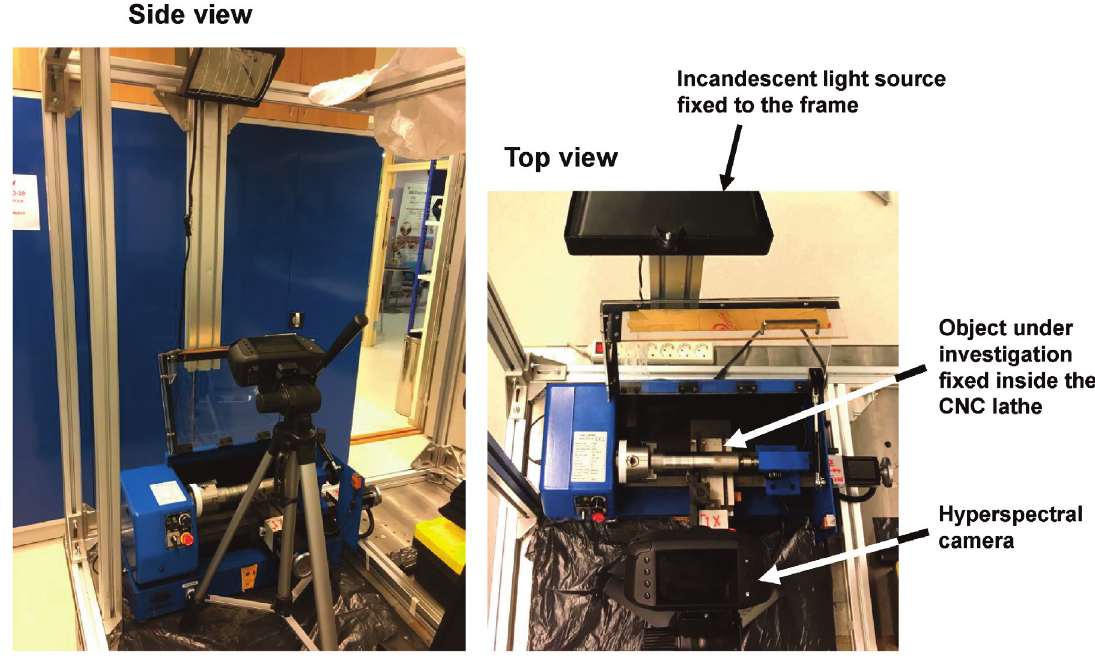
Fig. 2. Test setup for hyperspectral investigation during the cutting test (side and top